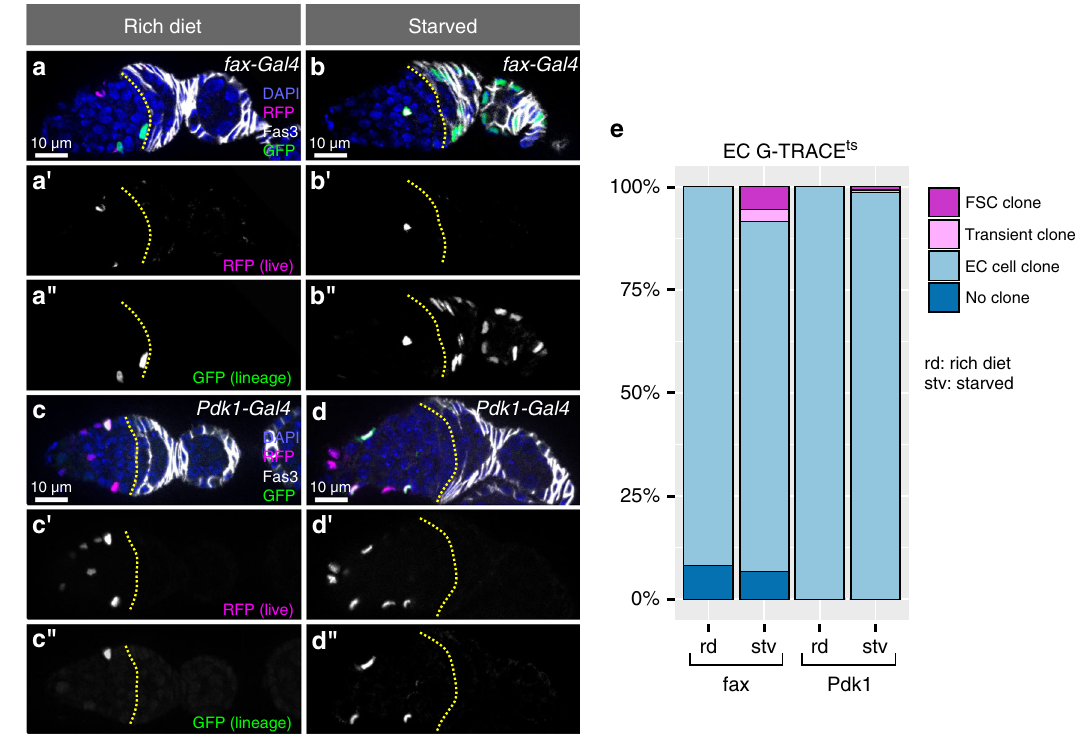
Fig. 8 Posterior ECs convert to FSCs in response to nutrient deprivation. a – d Germaria from fl ies with fax-Gal4 ( a , b ) or Pdk1-Gal4 ( c , d ) driving G-TRACE ts stained for DAPI (blue), Fas3 (white), RFP (magenta), and GFP (green). a ’ – d ’ RFP channel in white. a ” – d ” GFP channel in white. Yellow line outlines the 2a/2b border. fax-Gal4 and Pdk1-Gal4 do not produce GFP + FSC clones on a rich diet (0 out of 5 fl ies with follicle cell clones) ( a , c ),